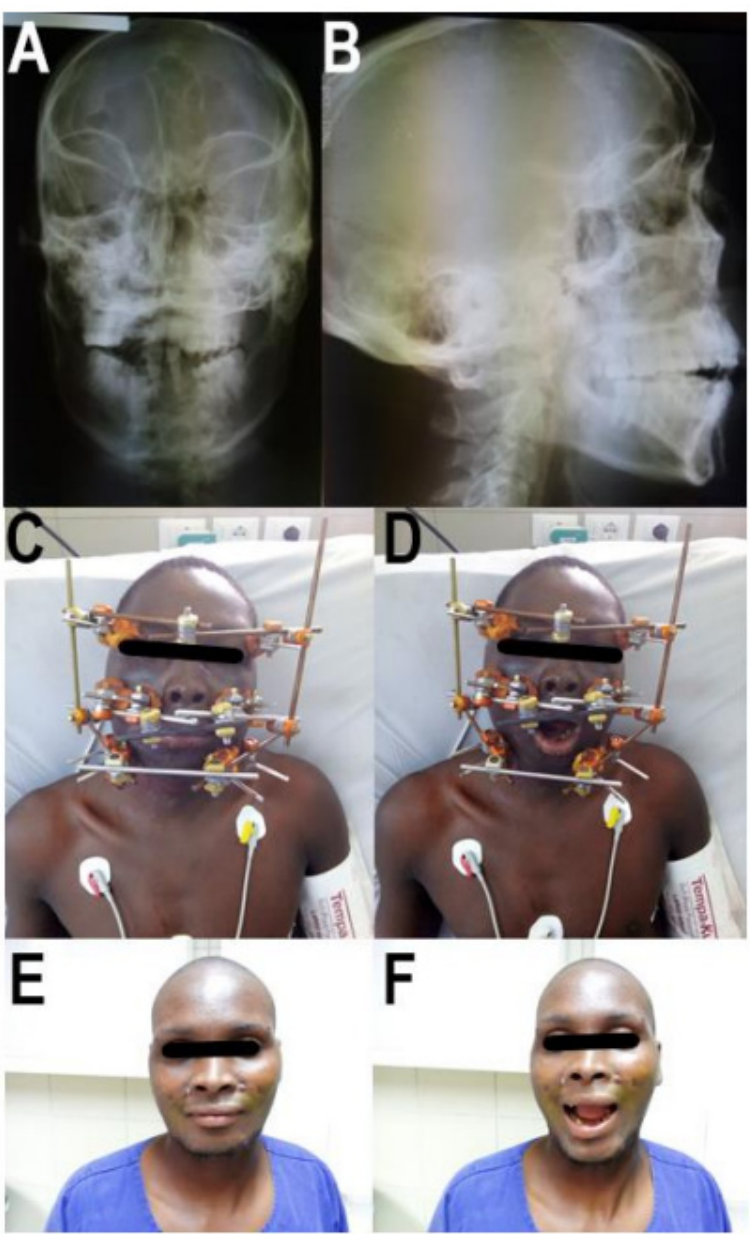
Figure 1. Case report of a patient with craniomaxillofacial fracture (CMF), treated with the External Face Fixator (EFF). Pictures ( A , B ) show preoperative radiographs of the skull in anteroposterior and lateral planes. Although a significant instability caused by a CMF is clinically diagnosed intraoperatively, the full extent is difficult to determine in the X-ray. Pictures ( C , D ) show the patient with the EFF in place and the range of motion of the temporomandibular joint during dynamic occlusion. Pictures ( E , F ) document the final result after removal of the fixator and fracture healing 8 weeks after the operation.